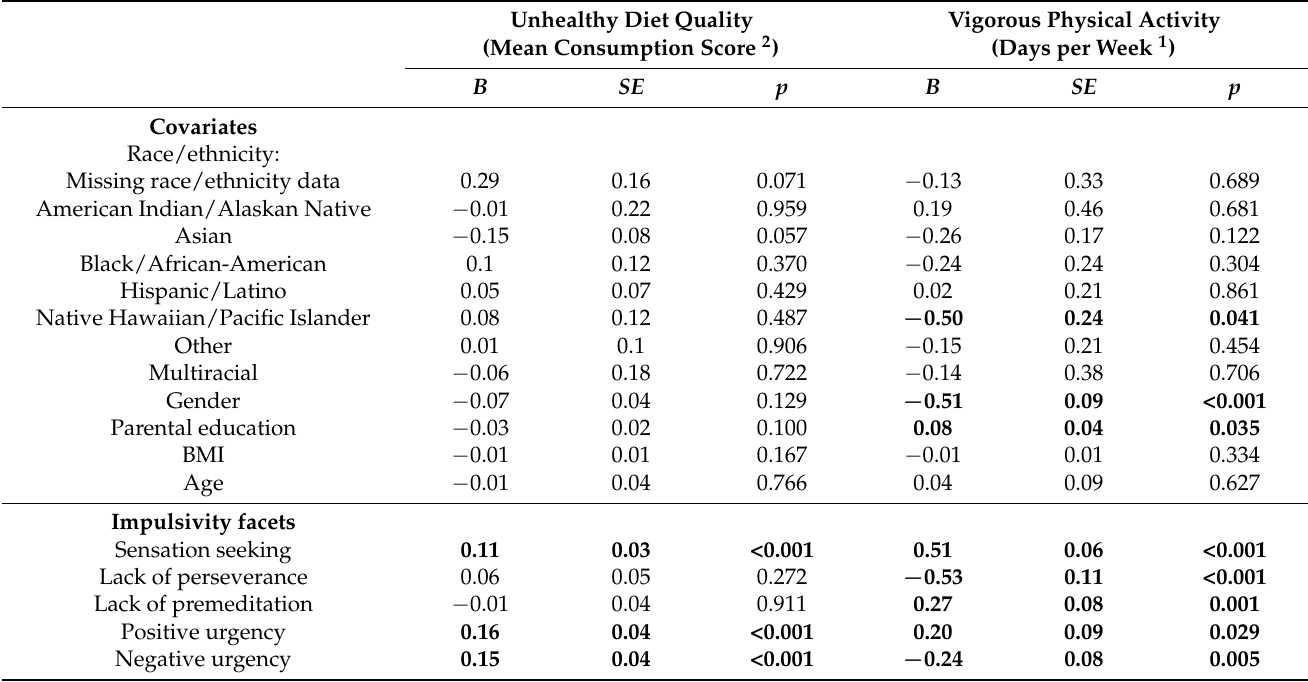
Table 2. Results from mixed models examining associations of impulsivity facets and covariates with unhealthy diet quality and vigorous physical activity